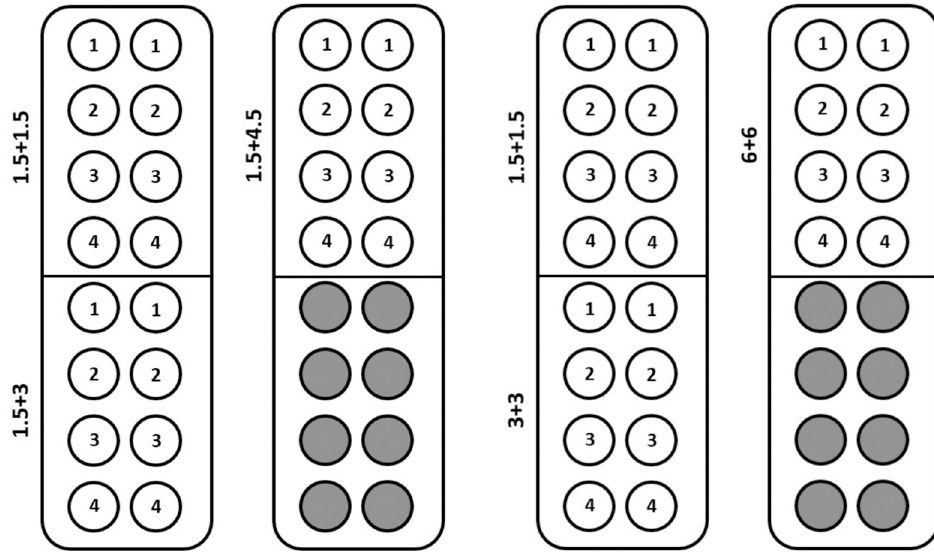
Fig 3. Example of 20 μ l Nucleocuvette ™ Strip layout. Experiments where (A) optimal ratio of gRNA to CRISPR/Cas protein required for precomplexing will be determined, (B) the optimal amount of recombinant CRISPR/Cas will be determined (if we assume the optimal ratio will be 1:1). All experiments will be performed in duplicate, 4 gRNAs will be used for RNP formation (AAVS1, CDK4 and HPRT1 and non-targeting control